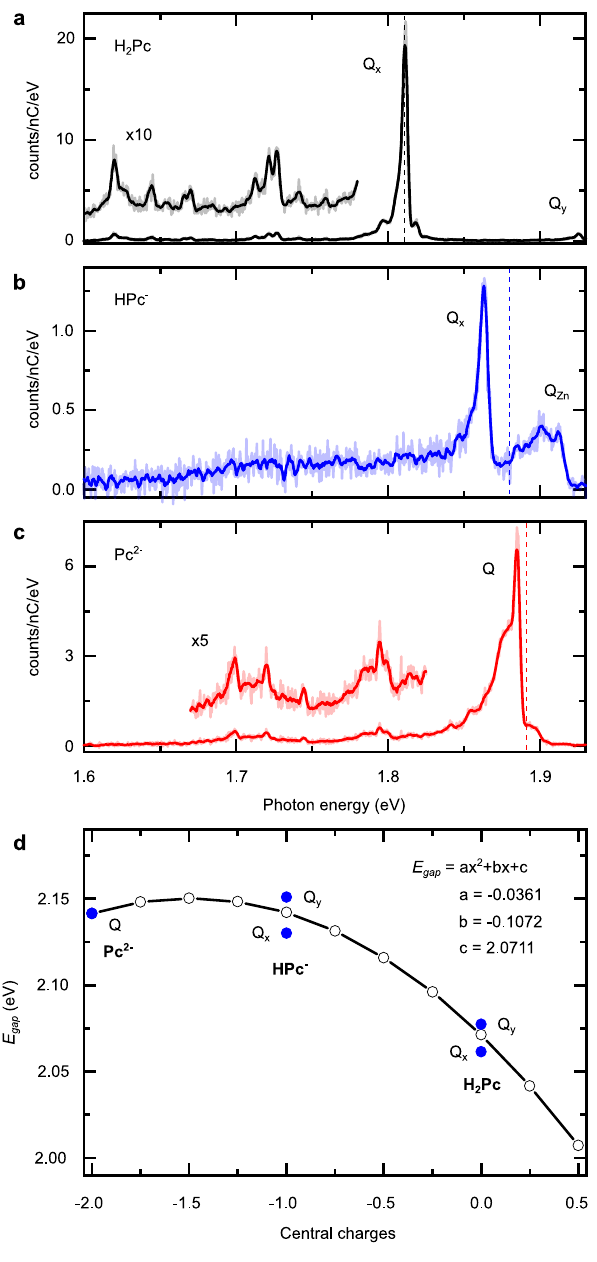
Fig. 3 ISE in fl uorescence spectra of neutral and charged phthalocyanines. STML spectra (acquisition time t = 120 s) of ( a ) H 2 Pc ( I = 100 pA, V = − 2.5 V), ( b ) HPc − ( I = 60 pA, V = − 2.5 V), and ( c ) a Pc 2 − ( I = 100 pA, V = 2.5 V) on 3ML NaCl/Ag(111). The spectrum of HPc − was obtained by resonant energy transfer from a neighboring ZnPc. The vertical dashed lines correspond to TD-DFT calculations of the S 0 → S 1 absorption energies for H 2 Pc, HPc − , and Pc 2 − , rigidly shifted by − 250 meV to fi t the experiment. This shift can be rationalized by considering that the dynamical screening linked to the presence of the NaCl/Ag(111) substrate and of the STM tip are not accounted for by our theoretical approach. While this prevents a quantitative comparison between experimental and theoretical energies, this procedure shows that theory accurately predicts the energy shift upon deprotonation. d Comparison between TD-DFT absorption energies calculated for H 2 Pc, HPc − , and Pc 2 − (blue dots) and TD-DFT absorption energies calculated for a Pc 2 − as a function of partial positive charges added arti fi cially in its center (white dots). The line through the white dots is a parabolic fi t with the parameters given in inset. Source data are provided as a Source Data fi